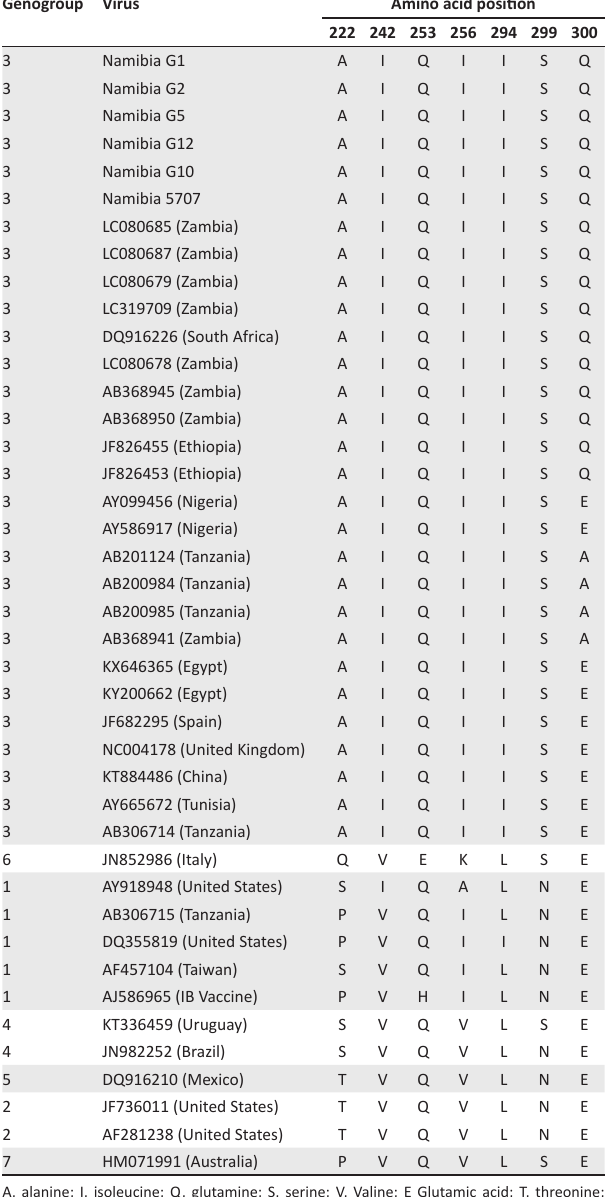
TABLE 2: Comparison of amino acid residues of the VP2 between the samples investigated and other infectious bursal disease viruses. Genogroup